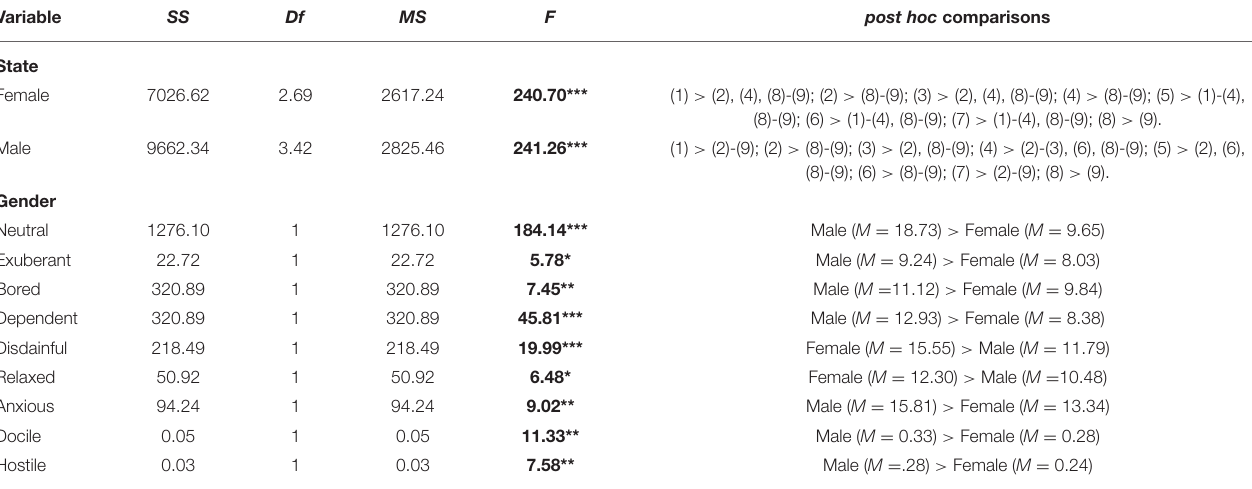
TABLE 9 | Simple main effect test of mixed design of gender and emotional states in Shimmer%. Variable SS Df MS F post hoc comparisons